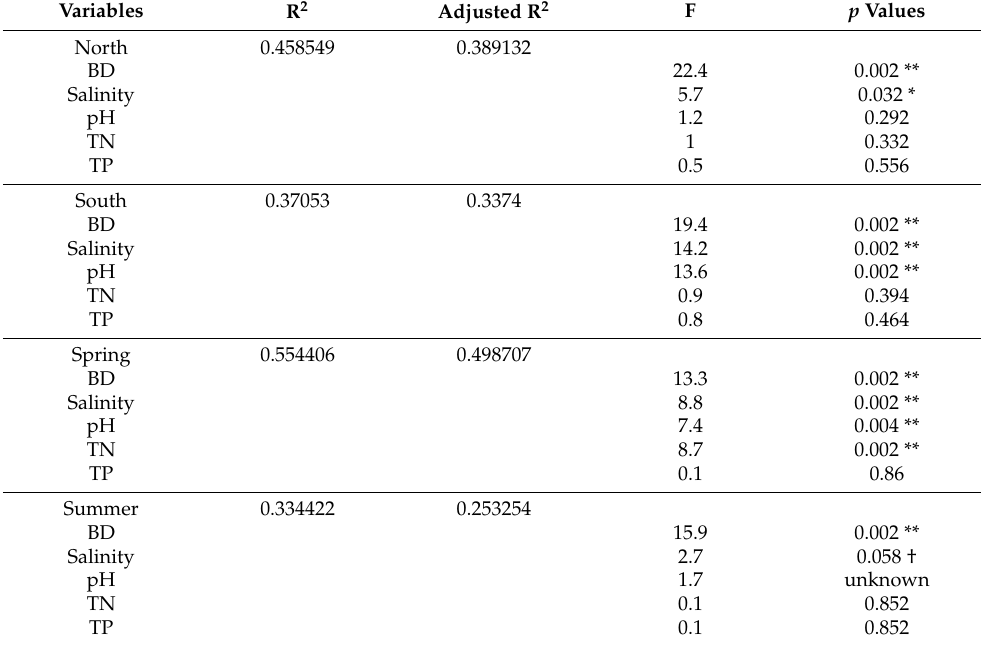
Figure A1. A two-dimensional graph of RDA ordination for communities and soil factors in different regions and seasons: ( a ) north; ( b ) south; ( c ) spring; ( d ) summer; ( e ) autumn; and ( f ) winter. The cumulative interpretation rates of the two sorting axes are labeled on the axis labels. Different colors represent different communities. The red axes represent the soil factors. The blue axes represent the species. The solid dots represent the soil factors corresponding to the communities. Table A2. Statistical results based on ANOVA of communities and environmental factors in